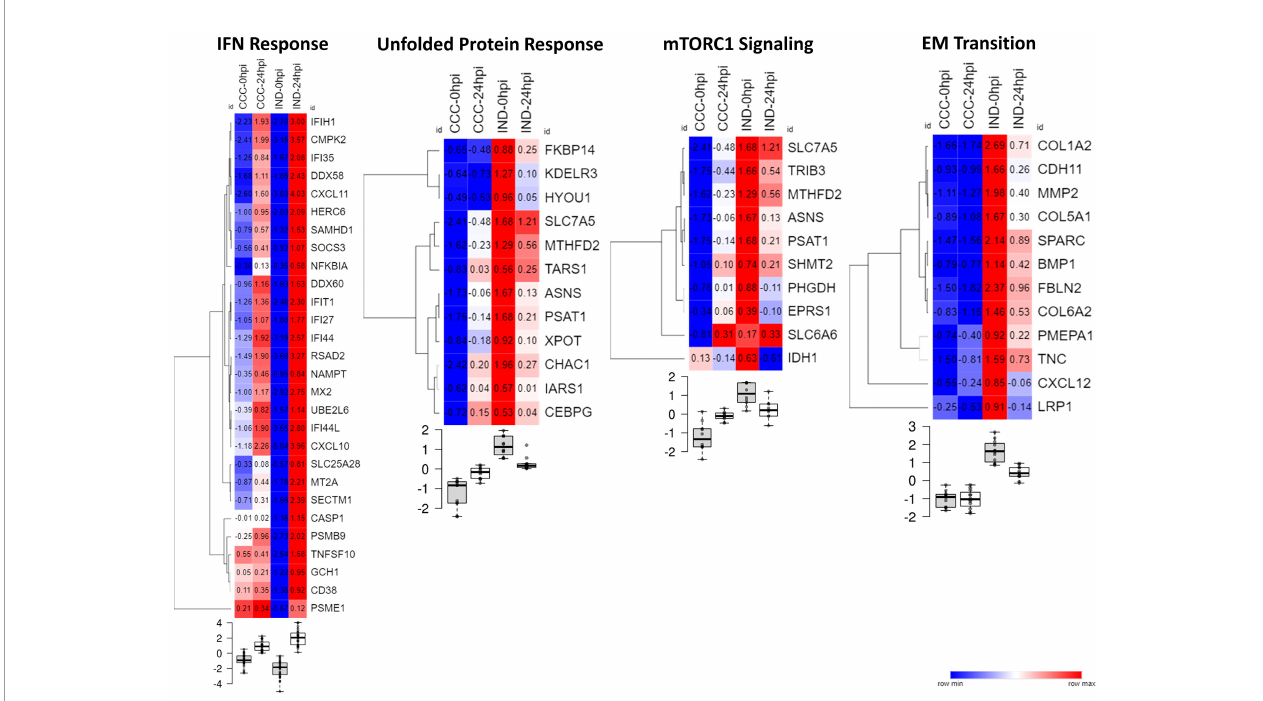
FIGURE 5 | Heat maps showing the normalize expression of signi fi cant DEGs across conditions in their respective Hallmark gene set. Samples were normalized by the mean counts. Below each heat map the boxplots show the level of gene expression at every time point (0 or 24 hpi) for each group (CCC or IND).